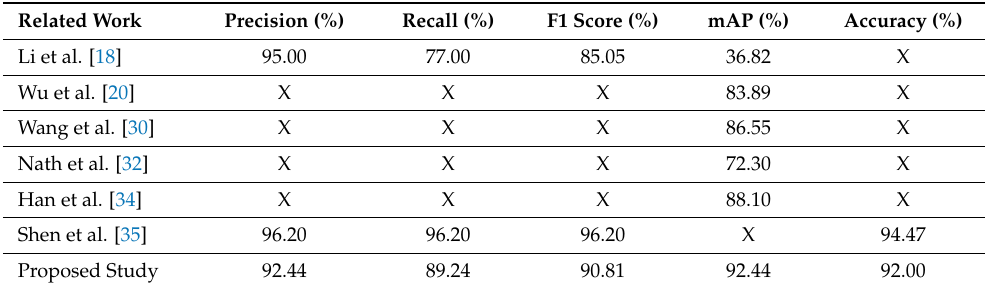
Table 4. Comparison of Proposed Model with other state-of-the-art models Based on Deep Learn- ing